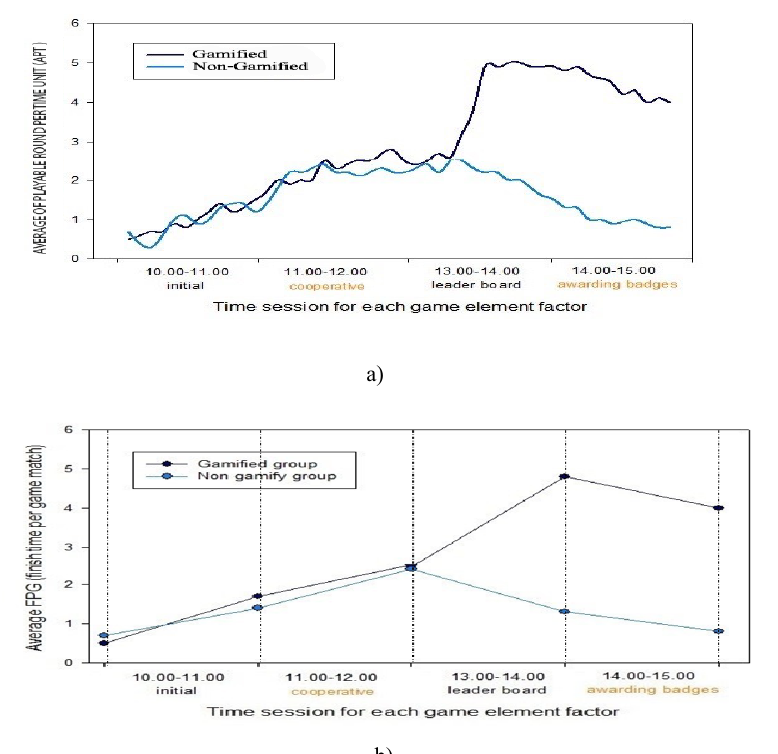
Fig. 7. Graph average: (a) and Normalized slope (b) of playable round per time unit (APT) of Gamified and Non-Gamified